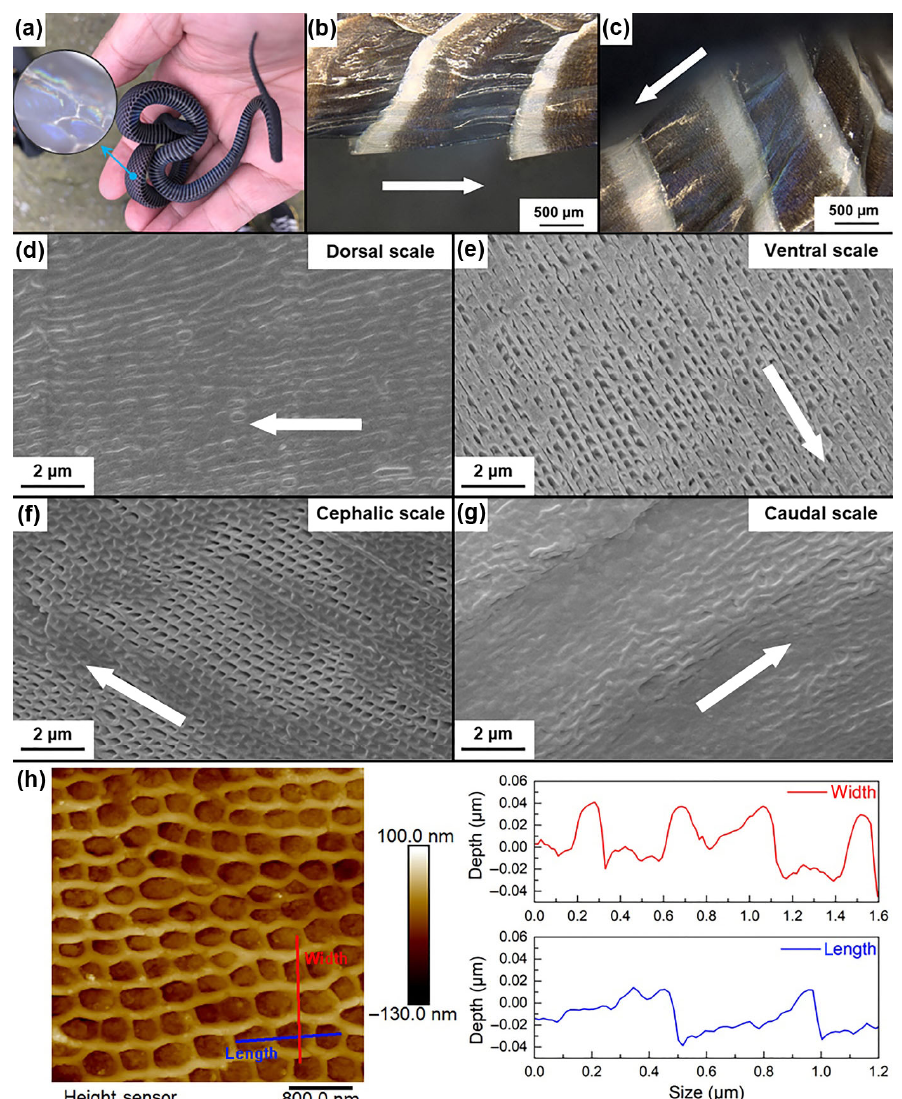
Fig. 1 (a) Structural color of Achalinus spinalis cuticle; (b, c) microscopic images of ventral scale for Achalinus spinalis ; (d–g) SEM images of dorsal scale, ventral scale, cephalic scale, and caudal scale for Achalinus spinalis ; and (h) AFM images of Achalinus spinalis cuticle and the width, length, and depth profiles along the corresponding